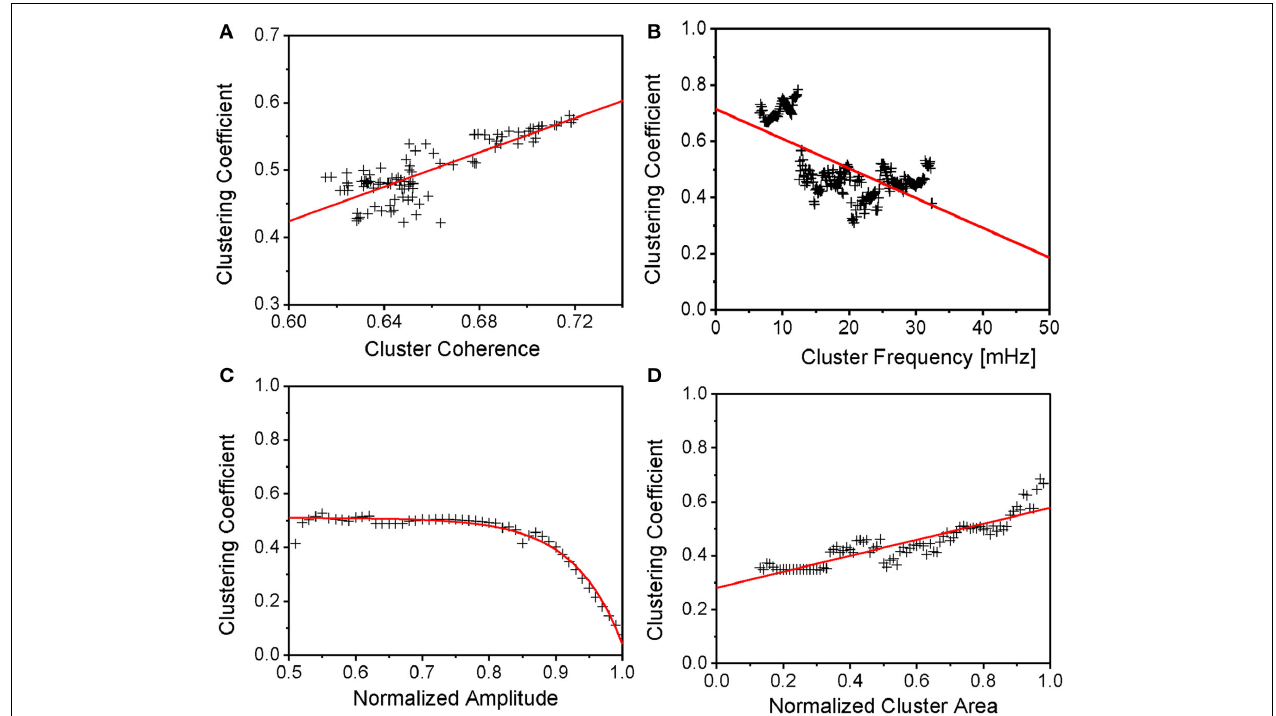
FIGURE 4 | Major Cluster Properties in Relation to Mean Mitochondrial Clustering. (A) Mean clustering coefficient vs. major cluster coherence. Though cluster coherence variability is limited, mean clustering still increases naturally for increasing cluster coherence. (B,D) Mean clustering coefficient vs. major cluster frequency and normalized cluster area. Clustering is shown to increase with cluster area and, therefore, number of cluster mitochondria. In analogy to Figure 2 in Kurz et al. (2010a), clustering then decreases with increasing cluster frequencies. (C) Mean clustering